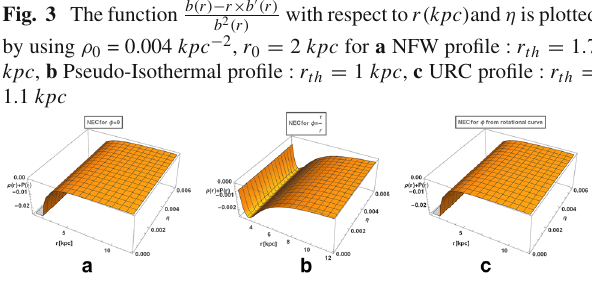
Fig. 4 NEC with respect to r ( kpc ) and η is plotted by using ρ 0 = 0.004 kpc − 2 , r 0 = 2 kpc , r th = 1 . 7 kpc , k 1 = k 2 = 1, α = 0 . 8, β = 0 . 001 and τ = 2 . 5 for NFW profile